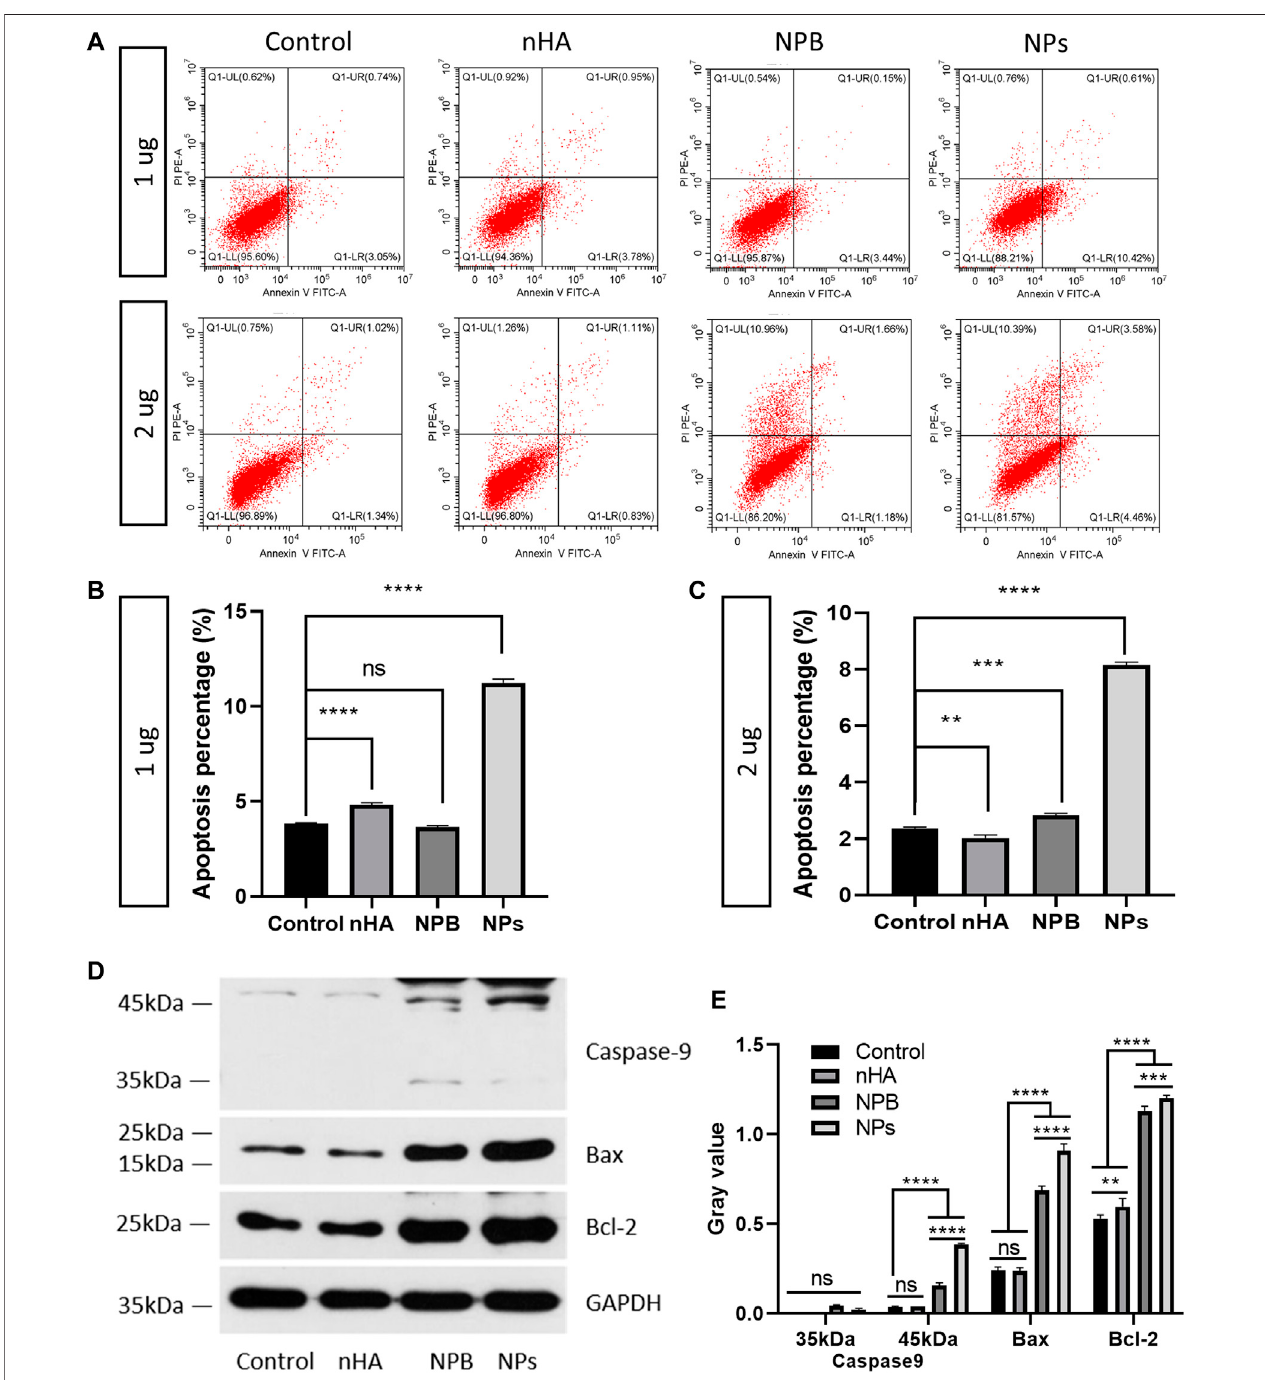
FIGURE 3 | Nanoparticles promote the apoptosis of osteosarcoma cells. (A) Flow cytometry results of 143b cells treated with 1 and 2 μ g nanoparticles. (B,C) Apoptosis percentage of 143b cells treated with 1 and 2 μ g nanoparticles. (D,E) Western blot band and gray value of apoptosis related proteins. ns: non-signi fi cance, ** p < 0.01, *** p < 0.001, **** p < 0.0001.